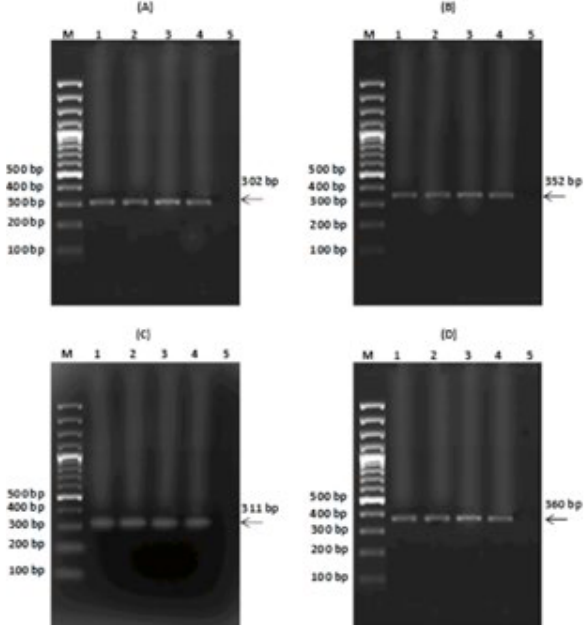
Figure 2. Agarose gel showing PCR amplifications from in - fected fig plants. (A) FMV, (B) FLMaV-1, (C) FMMaV and (D) FLMaV-2. M indicates the DNA ladder markers, lanes 1-4 are PCR-positive results from infected fig plants, lane 5 is the PCR-negative from asymptomatic fig